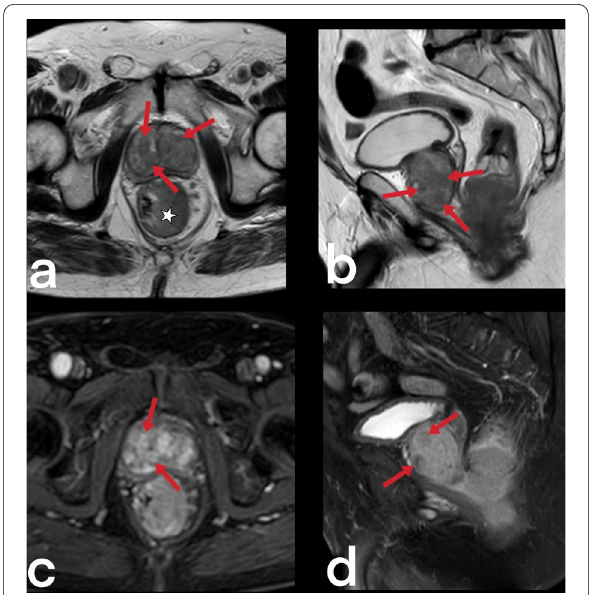
Fig. 39 Tuberculous prostatitis (abscesses) in a 53-year-old male. T2 weighted axial ( a ) and sagittal ( b ) MR images demonstrate focal, hypointense lesions within the prostate gland (arrows). Contrast-enhancement T1 weighted axial ( c ) and sagittal ( b ) MR images show heterogeneous lesions with peripheral enhancement (arrows). A rectal tumor (star) is also seen